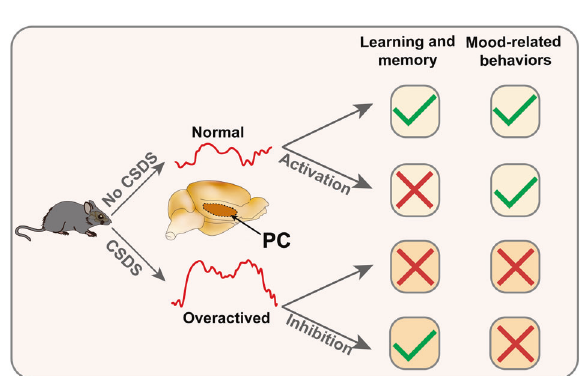
Fig. 6 Schematic diagram for PC overactivation mediates CSDS- induced learning and memory behaviors but not mood-related behavior. After mice experienced chronic social defeat stress, the activity of PC-calcium signaling was increased, resulting in learning and memory impairment and mood-related disorders. Then, activation of PC CaMKII α expressing neurons results in learning and memory dysfunction in mice, but not mood-related disorders. Inhibition of PC CaMKII α expressing neurons in susceptible mice alleviated learning and memory impairment but had no signi fi cant effect on mood-related